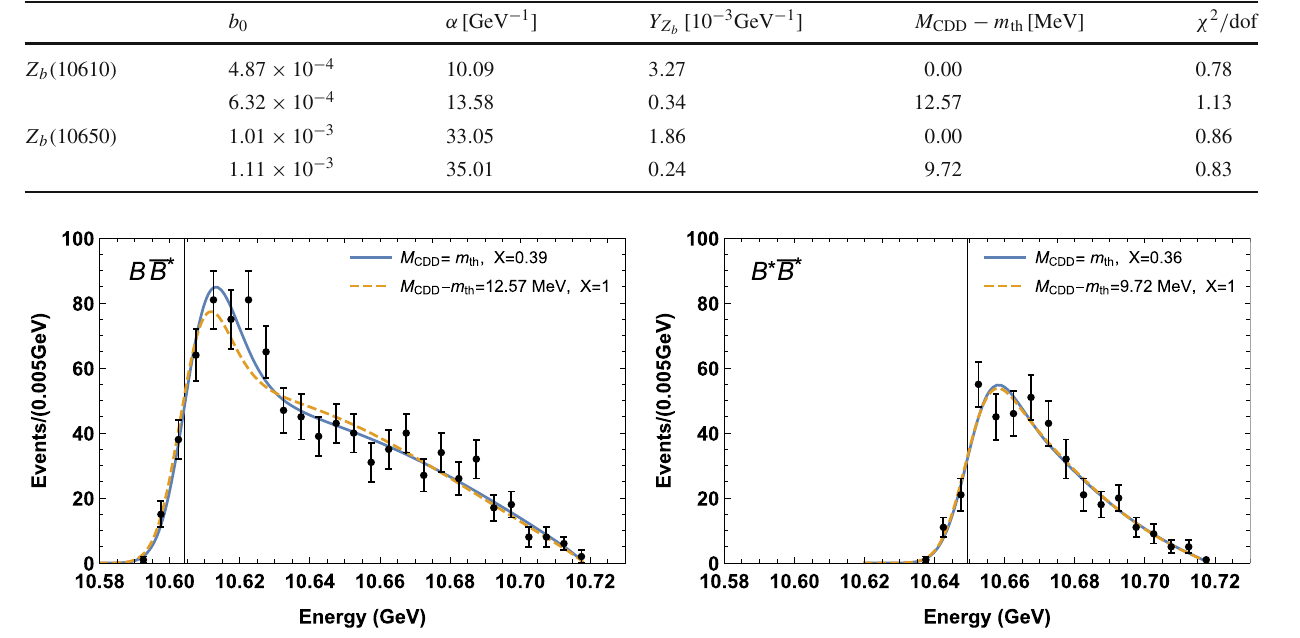
are given, while M CDD are fixed to be some b